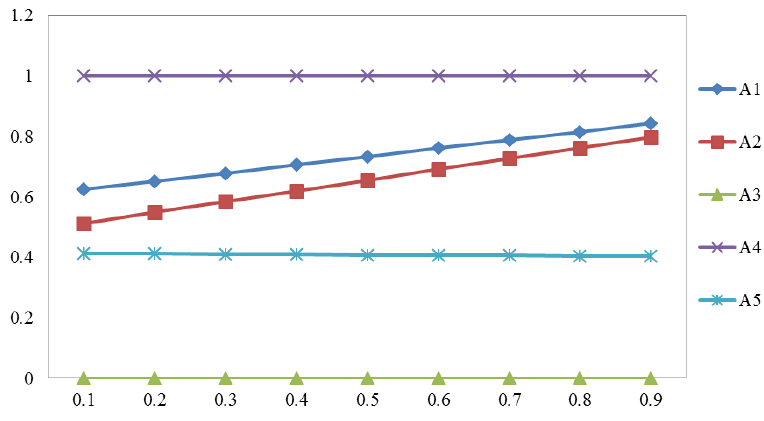
Figure 4. Sensitivity analysis of v value for each alternative.